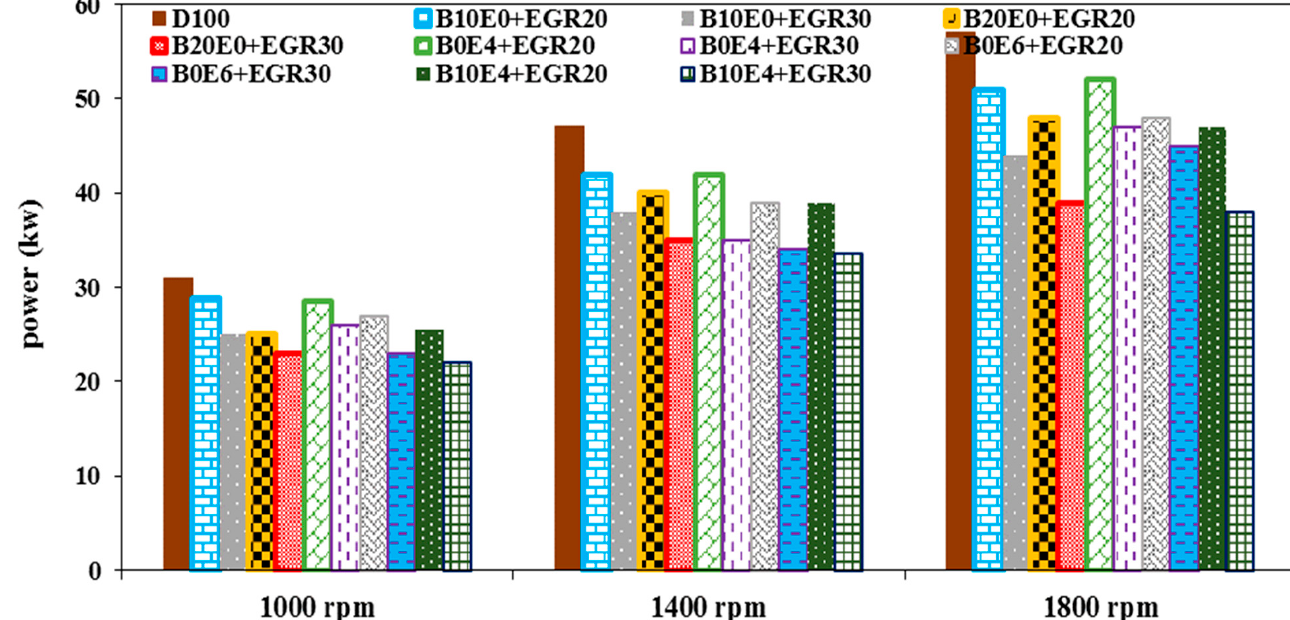
Figure 2. Variation of power for diesel/ethanol/biodiesel blends at EGR = 20, 30%, and various engine speeds.